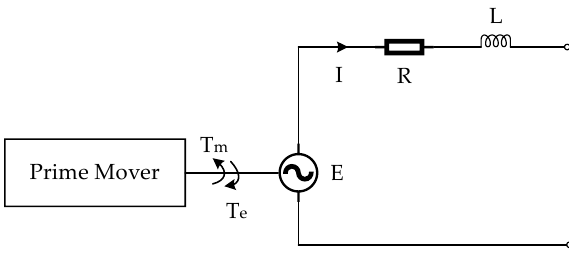
Figure 3. Simplified model of synchronous generator.